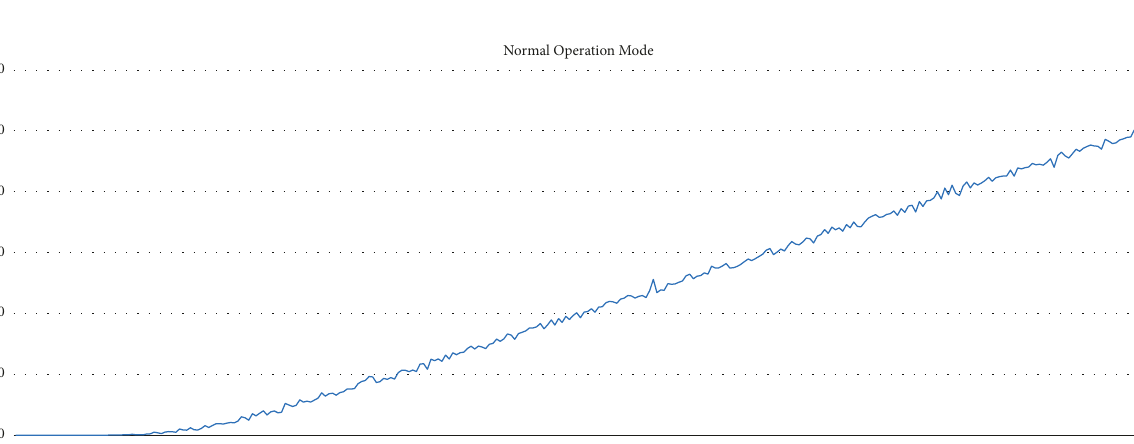
Figure 6: Maximum reward obtained for the normal operation mode of the IPR in one year of